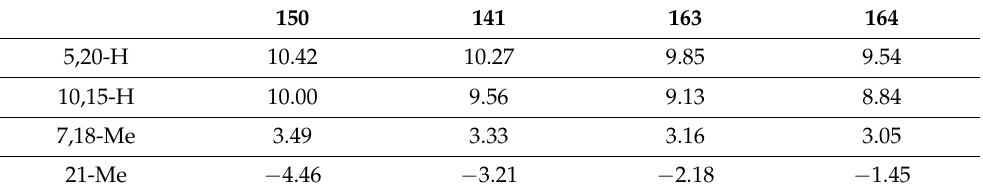
Table 1. Selected proton NMR chemical shifts (ppm) for palladium(II) carbaporphyrins.